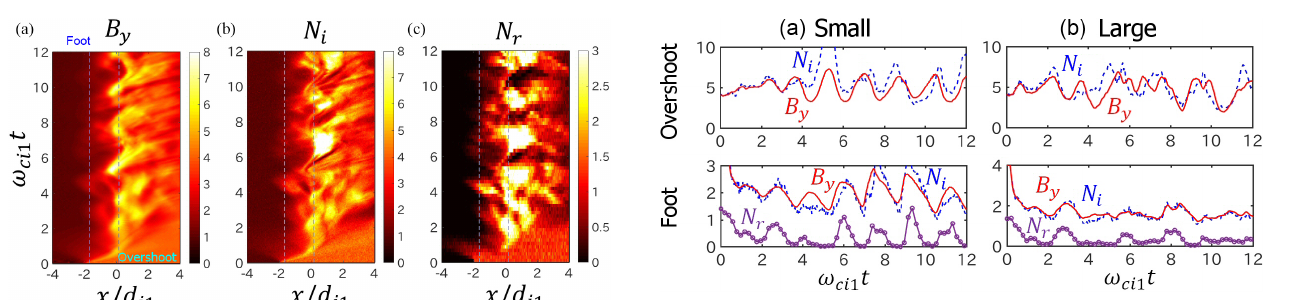
Figure 2. Development of a perpendicular shock at y/d i1 = 3 for Run A with the large simulation domain with the same format as Fig. 1. time t . The position and time are renormalized by the ion inertial length d i1 = c/ω pi1 and the ion cyclotron angular pe- riod 1 /ω ci1 , respectively. The magnitude is normalized by the initial upstream magnetic field B 01 .